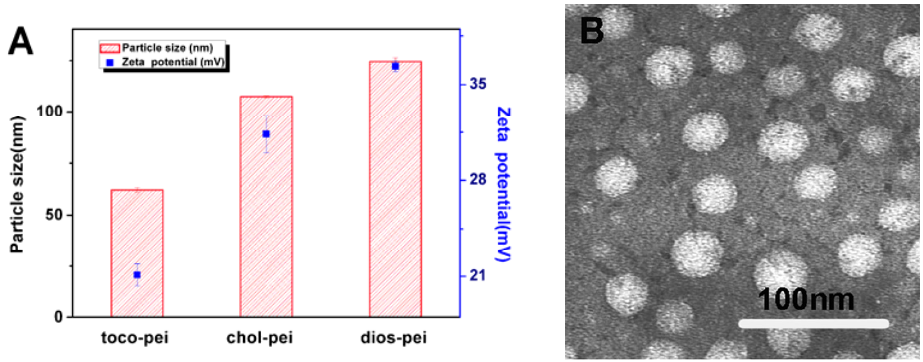
Figure 3. Particle sizes and zeta potentials of the three lipopolymers ( A ); TEM image of dios-pei , 80,000× magnification, 75 kV ( B ).